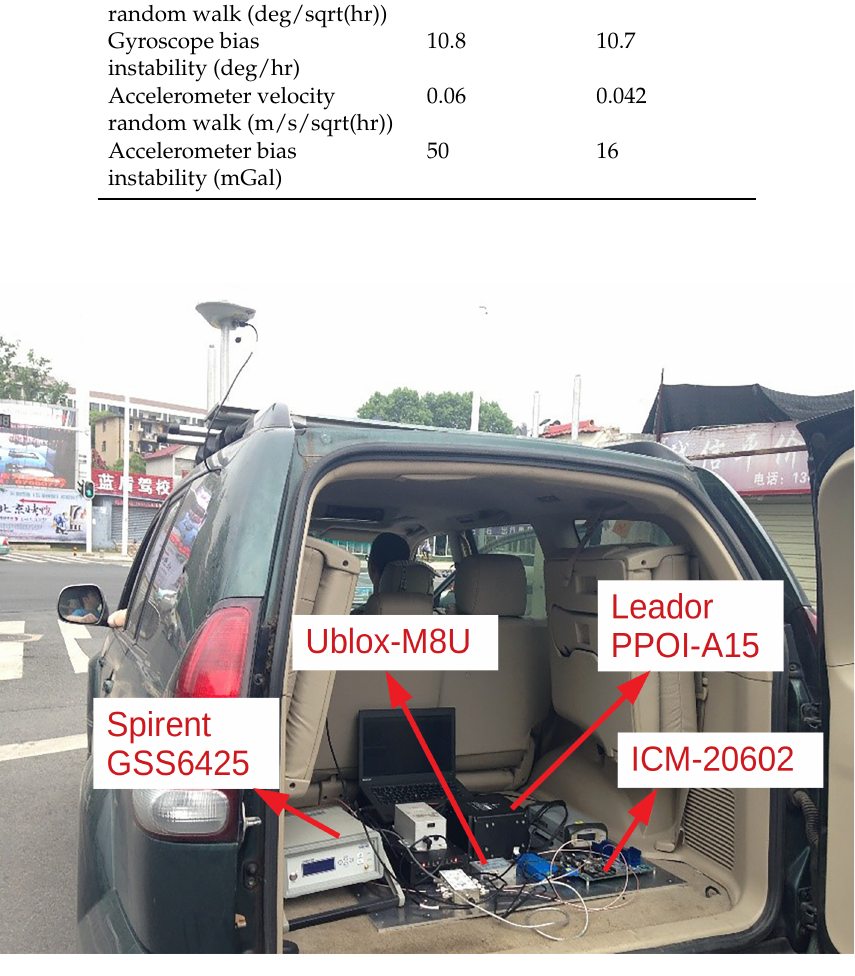
Figure 10. Testing vehicle and